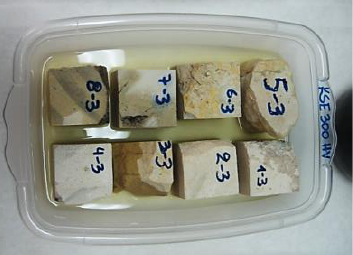
Figure 2. Representative stone specimens used in this work indicating the treatment of stone specimens via capillary